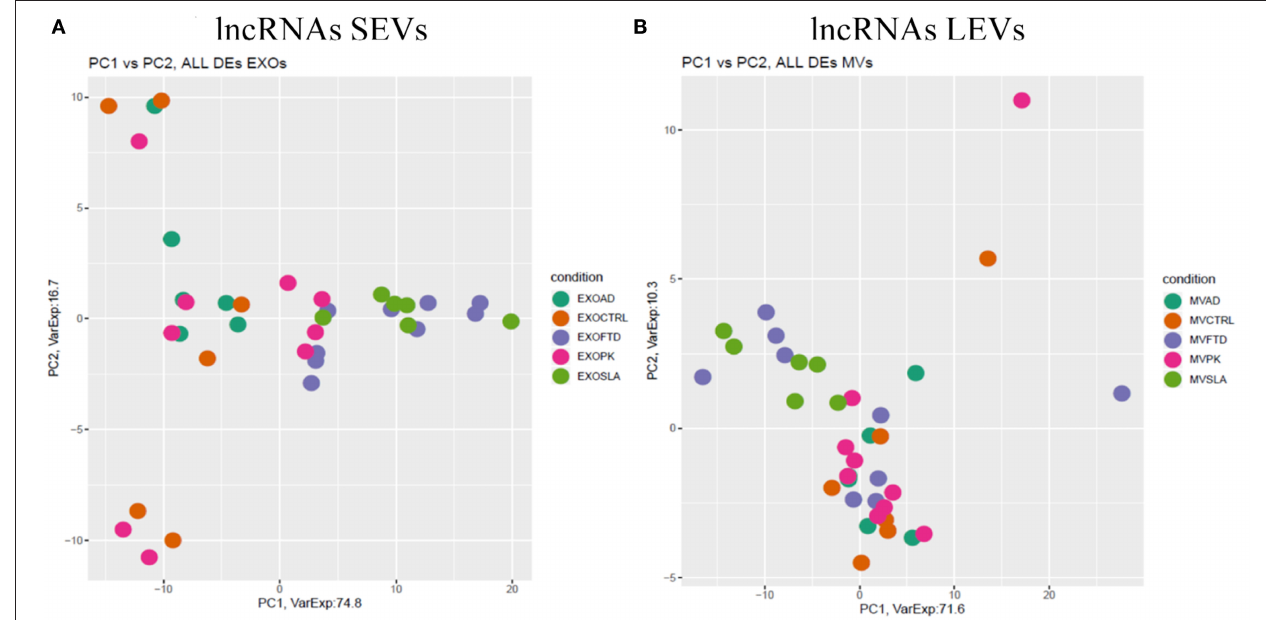
FIGURE 4 | PCA of long non-coding genes differentially expressed in SEVs (A) and LEVs (B) of patients with AD, FTD, ALS, and PD and healthy CTRs. PCA is performed using all DE long non-coding genes in at least one disease as predictors in the comparison of each disease to the control state. Each dot represents a sample, and each color represents a disease. Considering only lncRNAs, both SEVs and LEVs showed a mixed scenario between patients and controls, without any specific characterization of AD, FTD, ALS, or PD.